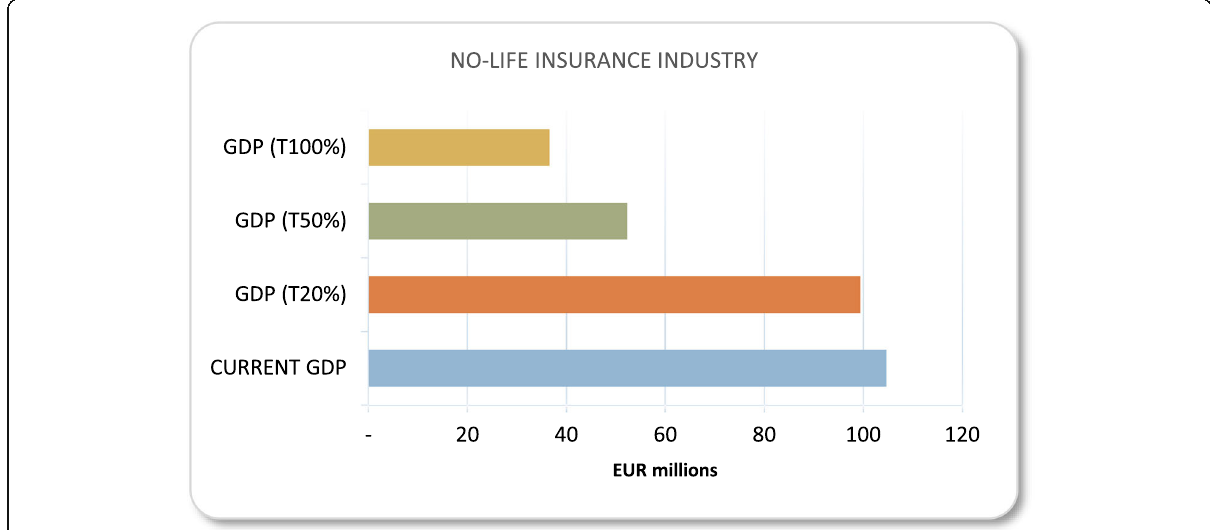
Fig. 13 GDP forecast of the Spanish no-life insurance